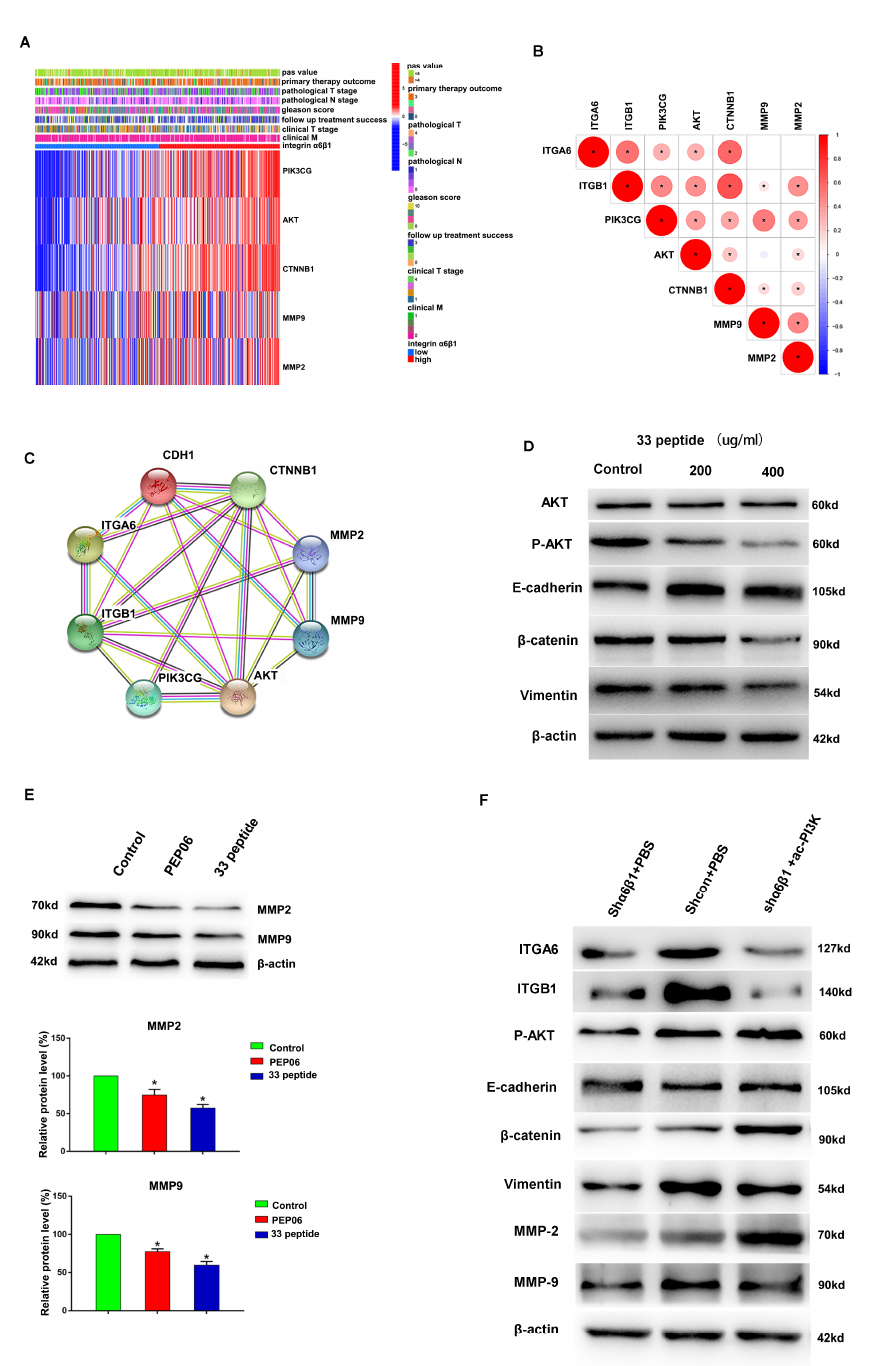
Figure 5. ( A ): PIK3CG, AKT, CTNNB1, MMP9 and MMP2 differentially expressed heatmap among the integrin α 6 β 1-high group and integrin α 6 β 1-low group. ( B ): Correlation analysis of ITGA6, ITGB1, PIK3CG, AKT, CTNNB1, MMP9 and MMP2. ( C ): PPI analysis of ITGA6, ITGB1, PIK3CG, AKT, CTNNB1, MMP9 and MMP2. ( D ): Western blot was used to detect the AKT, P-Akt, E-cadherin, β -catenin and Vimentin protein expression of different concentrations of the endostatin 33 peptide (200 µ g/mL and 400 µ g/mL) and 5% glucose solution groups in C4-2 cells. ( E ): Western blot was used to detect the MMP2 and MMP9 protein expression of the 33 polypeptide group, PEP06 group and 5% glucose solution group in C4-2 cells, respectively. ( F ): Western blot was used to detect the ITGA6, ITGB1, P-AKT, E-cadherin, β -catenin, Vimentin, MMP9 and MMP2 of the integrin α 6 β 1 knockdown group, integrin α 6 β 1 knockdown +PI3K activation group and control group in C4-2 cells. (* stands for p value <